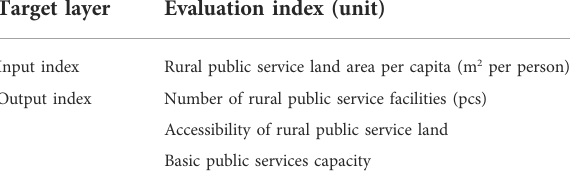
TABLE 2 Evaluation index system of allocation ef fi ciency of